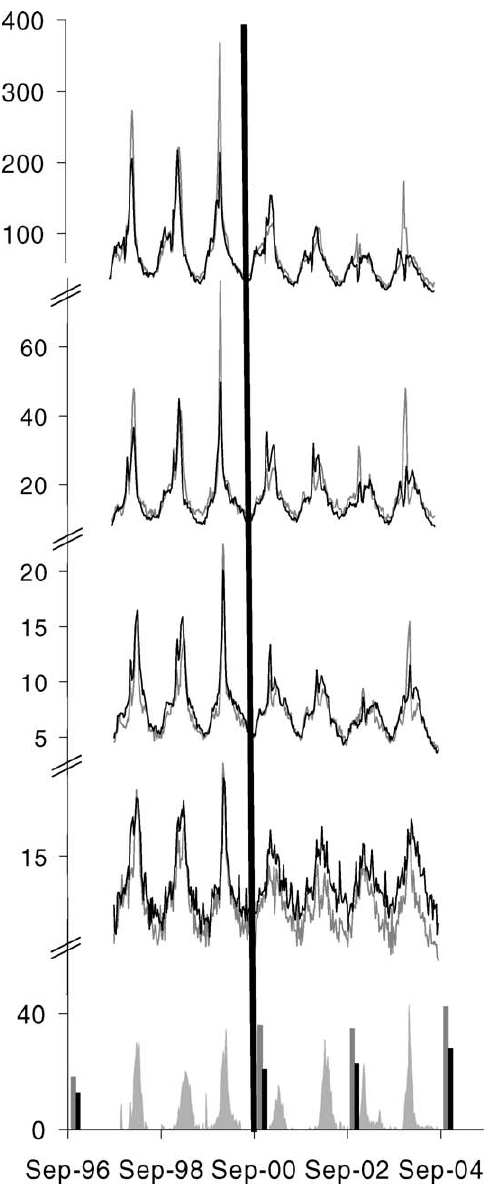
Figure 1. Study Outcome Rates over the Study Period Demonstrating Year-to-Year Variability in Mortality and Health Care Use, Temporal Correlation with Ontario Influenza Viral Surveillance Data, and Increasing Influenza Vaccination Rates Demonstrating Greater Increases in Ontario Compared to Other Provinces Combined Event rates (from top to bottom) for doctors’ office visits, ED use, hospitalizations, and mortality (grey lines are for Ontario and black lines are for other provinces combined) are expressed as rates per 100,000 on the upper sections of the vertical axis. Viral surveillance data (grey shaded areas) are expressed as the weekly percentage of tests positive on the lower section of the vertical axis. Vaccination rates for the household population aged (cid:2) 12 y (grey vertical bars are for Ontario and black vertical bars are for other provinces combined) are expressed as the percentage of the population vaccinated on the lower section of the vertical axis. The horizontal axis represents time. The black vertical line represents UIIP introduction.